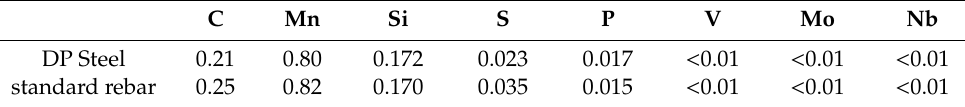
Table 1. Chemical composition of the studied steels (wt %).